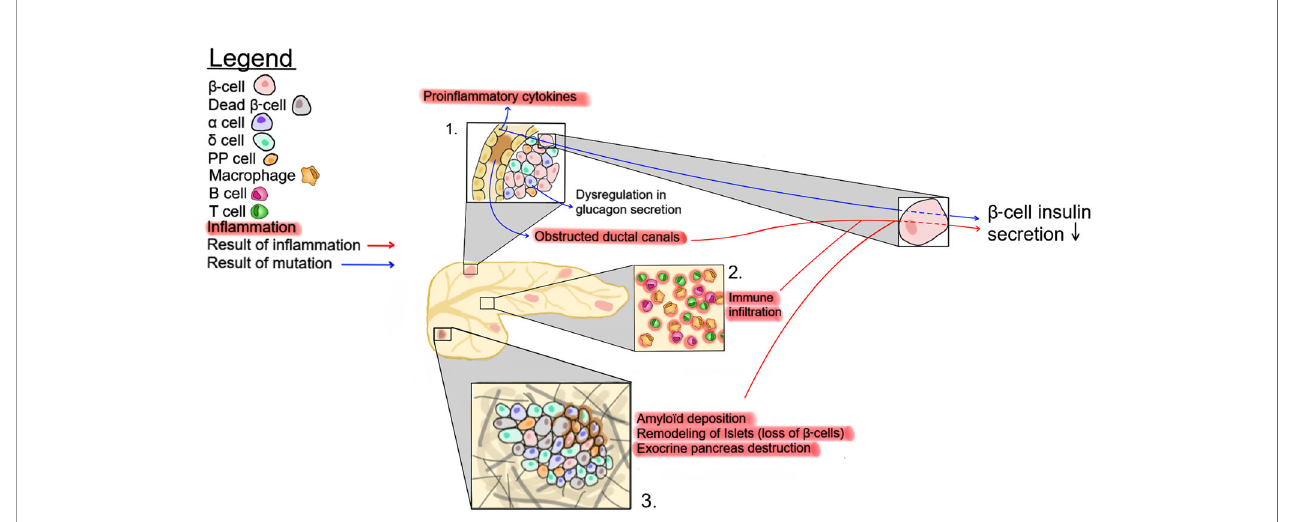
FIGURE 2 | Possible mechanisms affecting insulin secretion in CF patients. 1- CFTR mutations eventually lead to ductal obstruction, which causes an increase in proin fl ammatory cytokines. 2- The accrued immune in fi ltration in the pancreas of CF patients. 3- Changes in pancreatic tissue structure, such as amyloid deposition, exocrine tissue destruction and b -cell loss. These three pathways impact insulin production by b